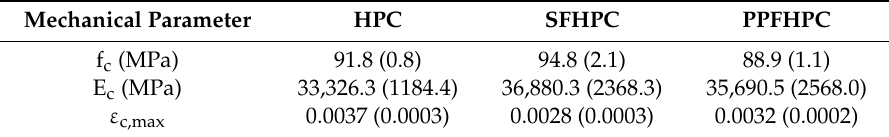
Table 2. Mechanical parameters of the concrete before starting the cyclic tests. L-Series.